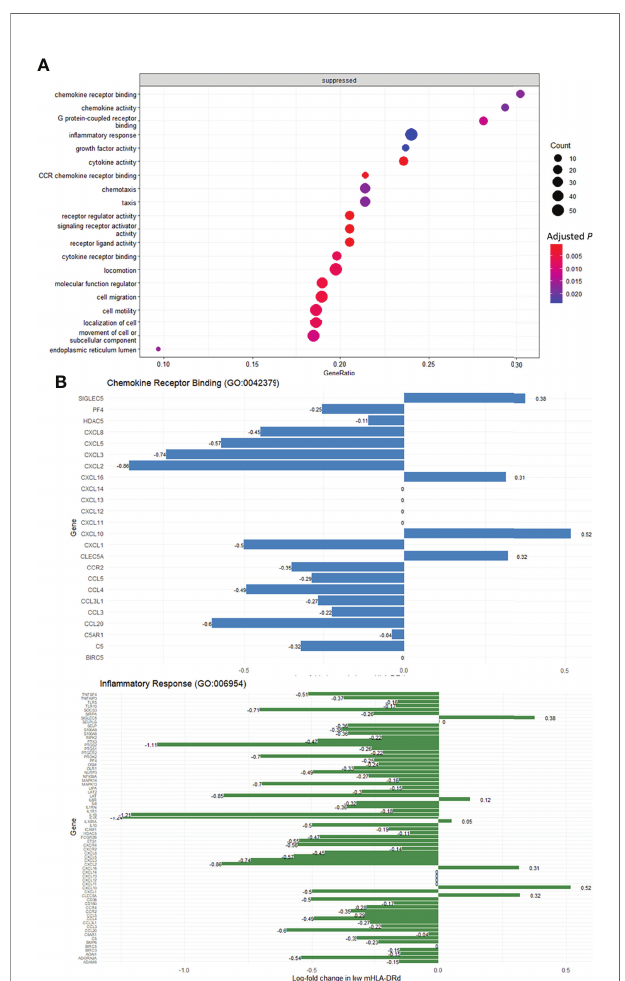
FIGURE 5 | Monocytes from RTR with low mHLA-DRd exhibit suppression of gene sets relating to in fl ammatory response and chemotaxis. (A) Pathways with signi fi cantly altered enrichment in RTR exhibiting low mHLA-DRd, using the Gene Ontology knowledge base. Pathways are listed in order of descending GeneRatio. (B) Differential expression of core genes in ‘ Chemokine receptor binding ’ and ‘ In fl ammatory response ’ Gene Ontology